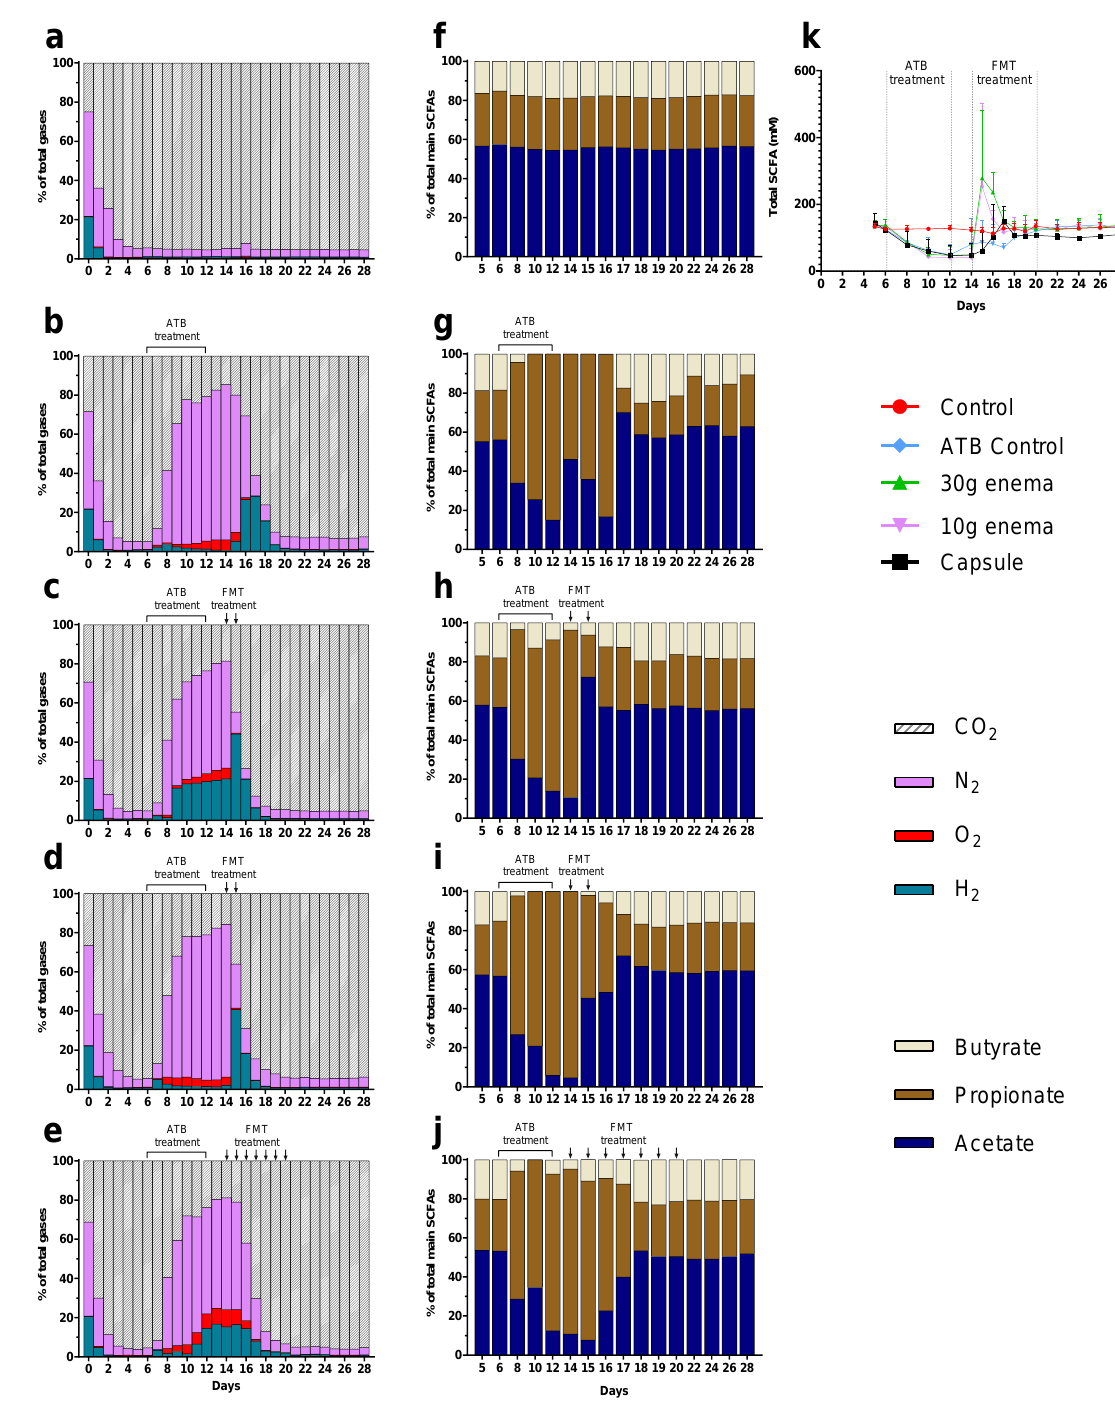
Figure 2. Effect of fecal microbiota transplantation (FMT) treatment on gas and short chain fatty acid (SCFA) production. Experiments were performed as described in Figure 1 and different conditions were applied: no treatment (control, subfigures ( a ) and ( f )), ciprofloxacin (ATB control, subfigures ( b ) and ( g )), ciprofloxacin and 30 g enema (subfigures ( c ) and ( h )), ciprofloxacin and 10 g enema (subfigures ( d ) and ( i )), and ciprofloxacin with oral capsules (subfigures ( e ) and ( j )). Gas composition was determined by gas chromatography and results expressed as mean relative percentages (subfigures ( a – e ), n = 3). Main SCFAs (acetate, propionate and butyrate) were analyzed by high performance liquid chromatography. Results were either expressed as mean relative percentages (subfigures ( f – j ), n = 3) or as total SCFA concentrations ± SEM (in mM, subfigure ( k ).